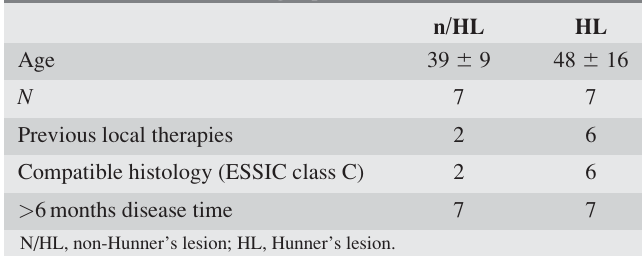
Table 1. Patient’s Demographics